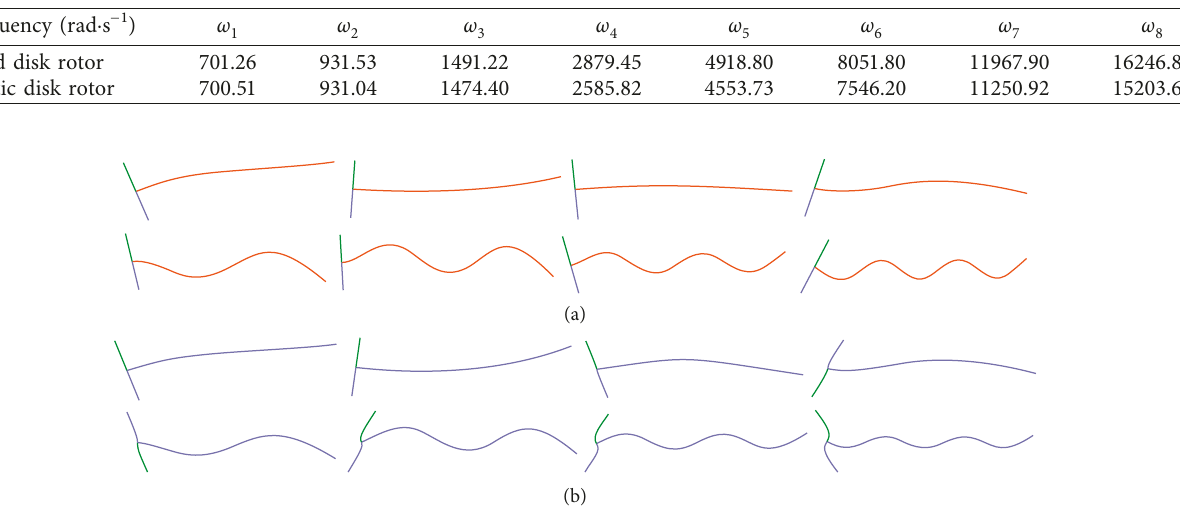
Table 1: First eight natural frequencies of the rigid disk and elastic disk rotor models.